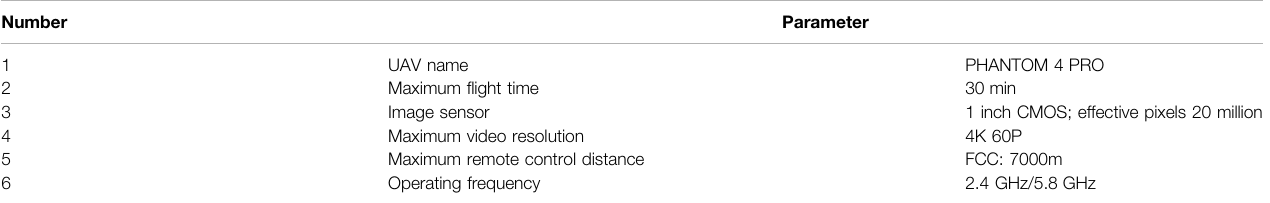
TABLE 2 | UAV parameters.